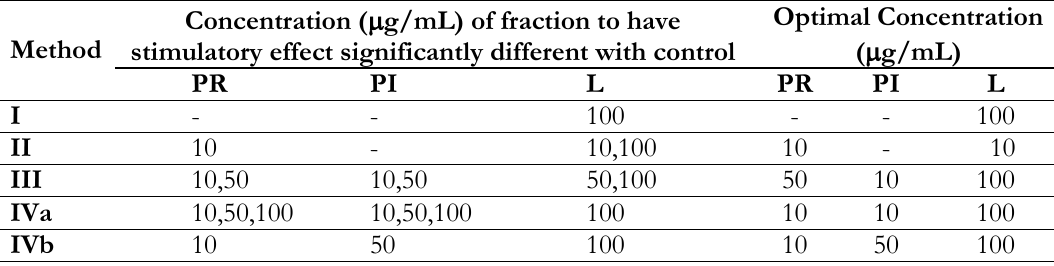
Table II. Result of Immunomodulatory activities if polysaccharide fraction of “Mengkudu”fruit